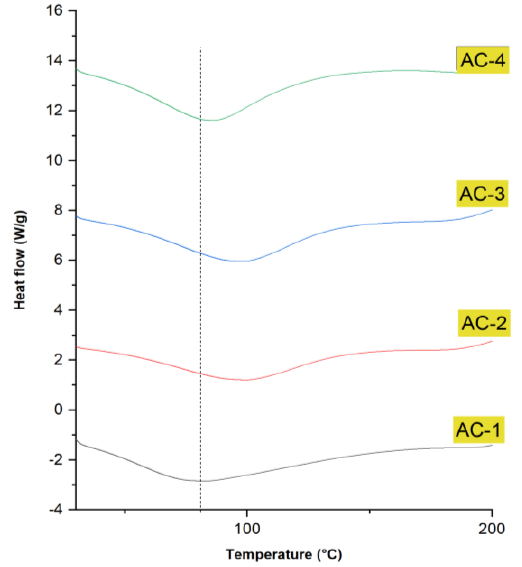
Figure 5. DSC analysis of SA–AG-based composite edible films; AC-1/Control, AC-2 contains 15 μL of CEO, AC-3 contains 20 μL of CEO, and AC-4 contains 30 μL of CEO.